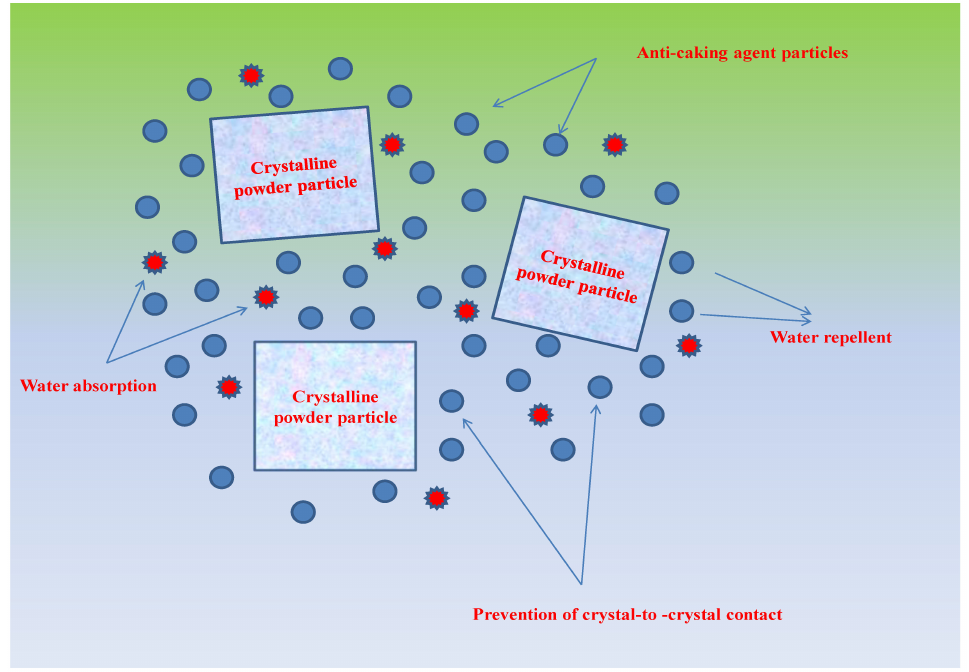
Figure 1. Mechanisms by which anticaking agents influence the water–solid interactions, preventing an increase in moisture